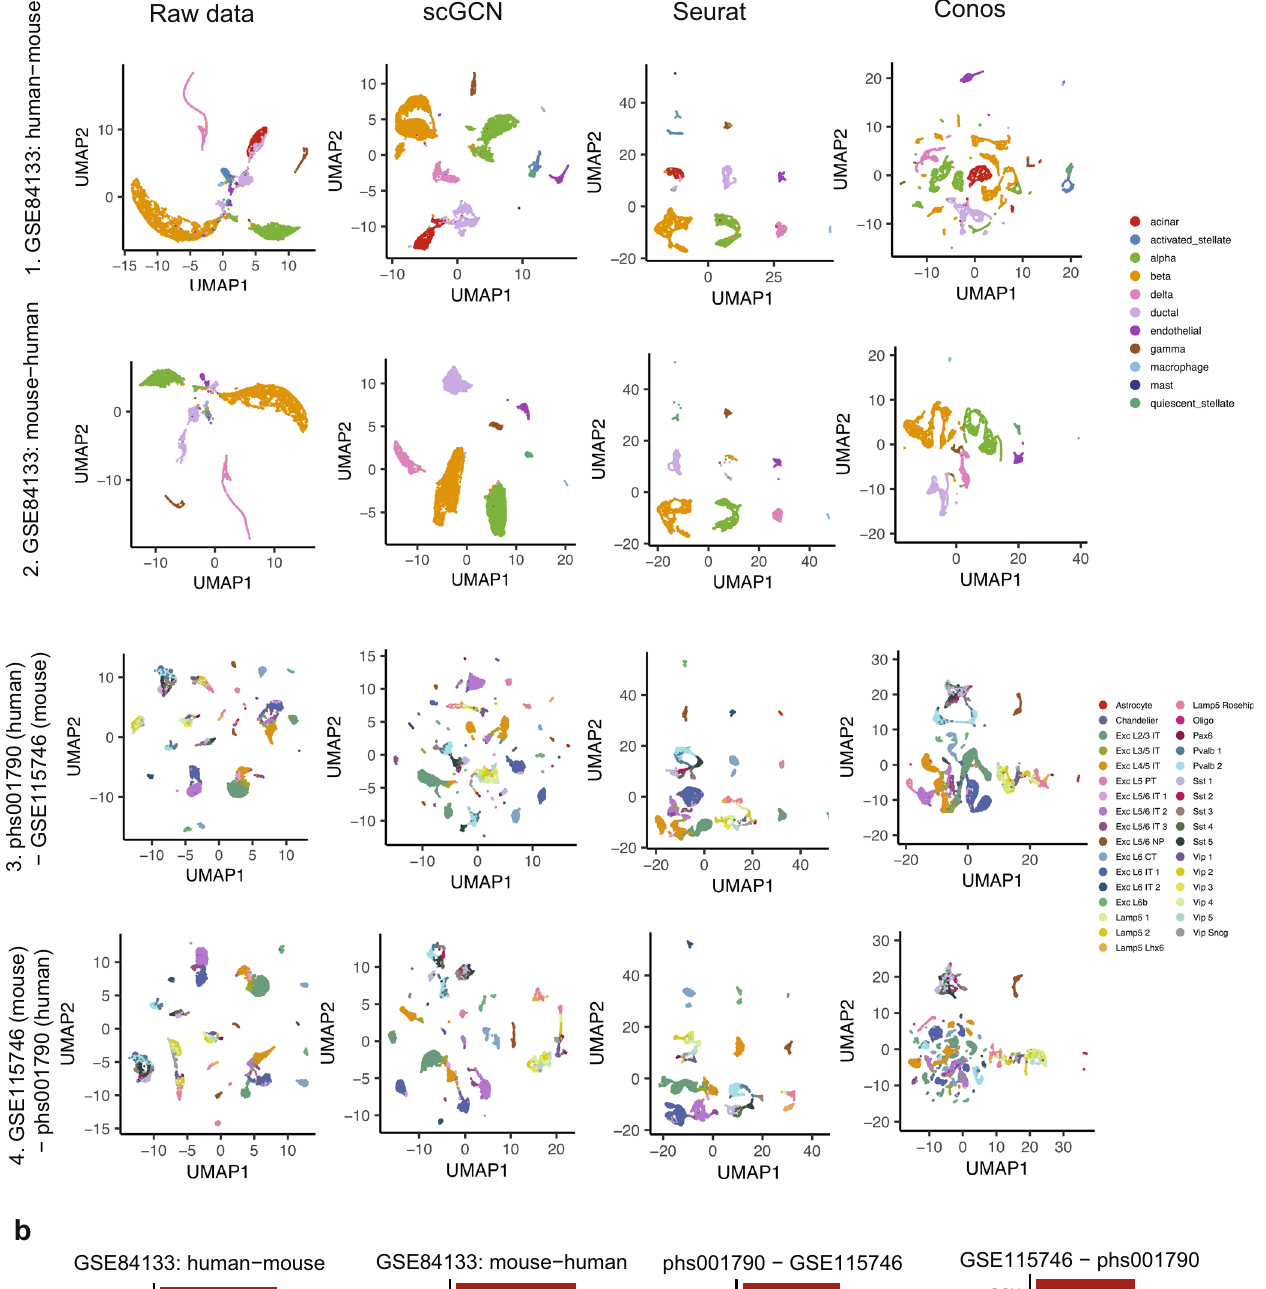
widths of each cell type 38,39 . A higher silhouette coef fi cient represents more differences between cell types and fewer var- iances within each cell type. Using these two metrics, we evaluate the transferred labels in each query dataset, i.e., scATAC-seq data. Compared to the other methods, scGCN shows better performance with higher